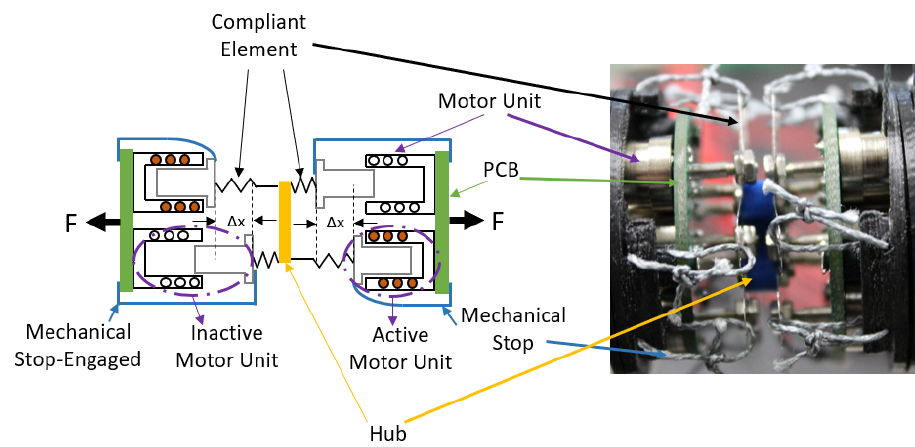
Figure 3. Actuation unit with annotated components.